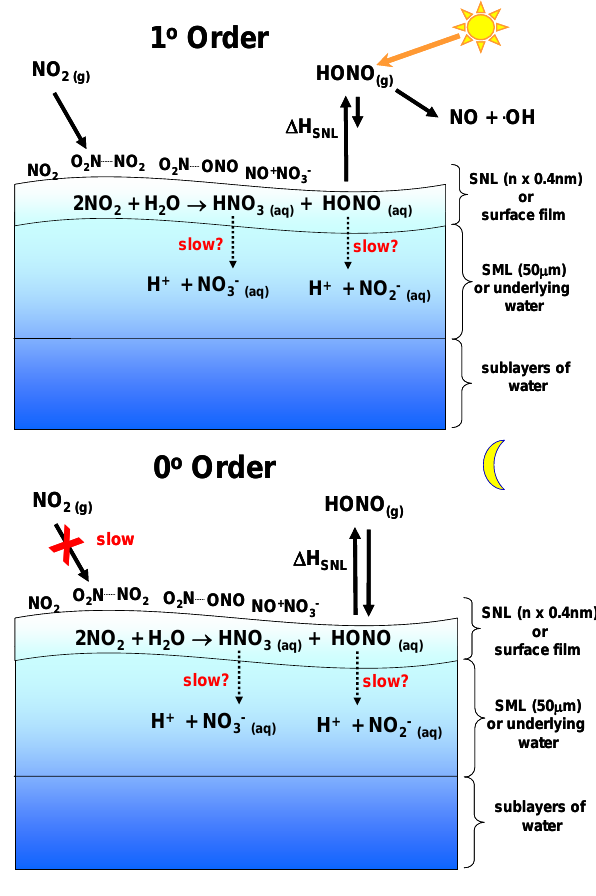
Fig. 9. Conceptual model of HONO formation mechanism on aque- ous surfaces. The sea surface nanolayer (SNL) or surface film is from 1 to n monolayers thick, and is highly acidic. Underlying layers include the sea surface microlayer (SML) in the case of the ocean or underlying water (dew, surface water, etc.) in the case of terrestrial surfaces, which would allow a medium for acid trans- port away from the SNL. (a) The formation of HONO is 1 ◦ order in NO 2 , when irreversible loss of HONO (i.e. photolysis) from the SNL is faster than deposition of NO 2 to the surface. (b) The for- mation of HONO is 0 ◦ order in NO 2 , (i.e. a static system), when the SNL is saturated in NO 2 precursors and irreversible losses of HONO from the SNL are negligible. HONO ( g ) is dependent on the equilibrium dictated by Henry’s Law for distribution of HONO between the SNL and gas